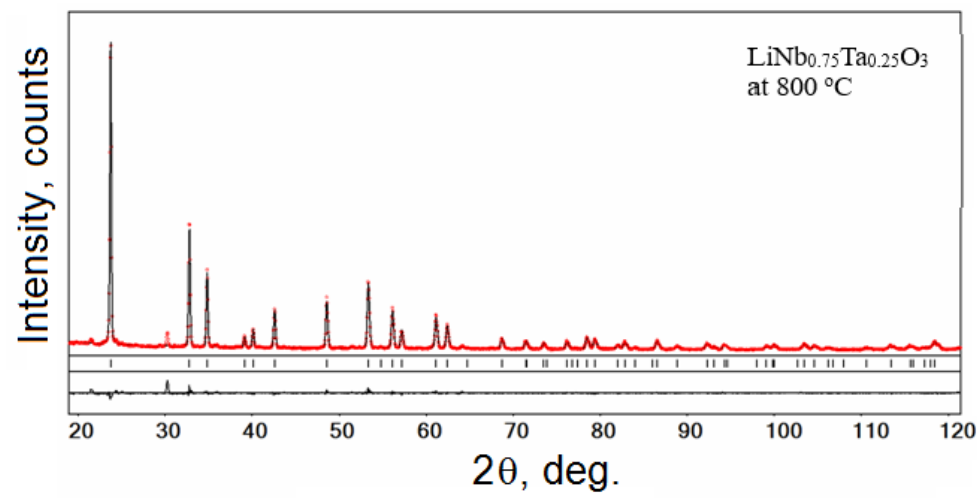
Figure 6. Results of Rietveld refinement of the LiNb 0.75 Ta 0.25 O 3 material heat treated at 800 °C. An experimental XRD pattern (dots) is shown in comparison with the calculated pattern. The difference between measured and calculated profiles is shown as a curve below the diagram. Short vertical bars indicate the positions of diffraction maxima in space group R 3 c.